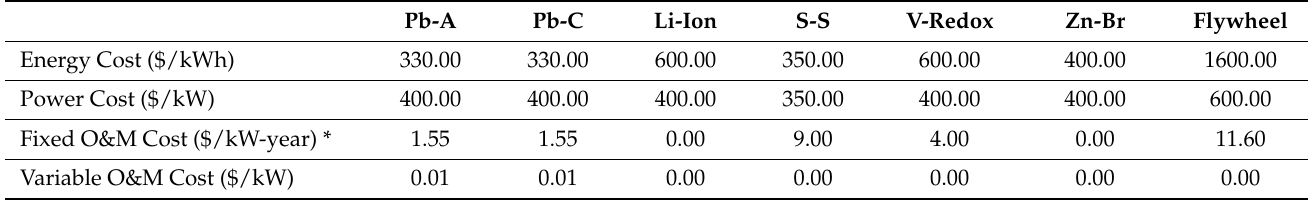
Figure 4. Cost comparison (USD/kW) of various battery technologies compared to other energy storage technologies. Table 2. Economic factors for energy storage technology considered in this study.